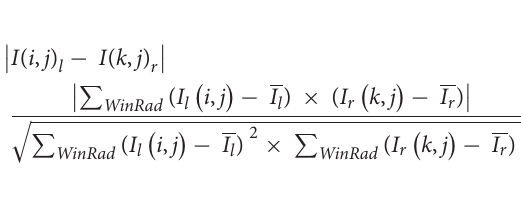
FIGURE 5 | Overview of the algorithm implemented to generate depth maps and reconstruct scenes from stereo images (Haralick and Shapiro,